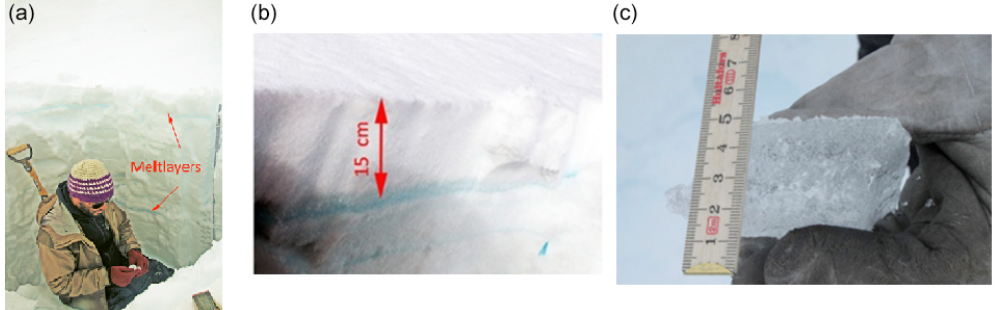
Figure 1. (a) View into the snowpit dug just after the 2012 rain/melt event at NEEM. The resulting melt layers occur in depths of around 15 and 70cm below the surface. (b) Close-up of the upper melt layer and (c) close-up of the 3.5cm thick